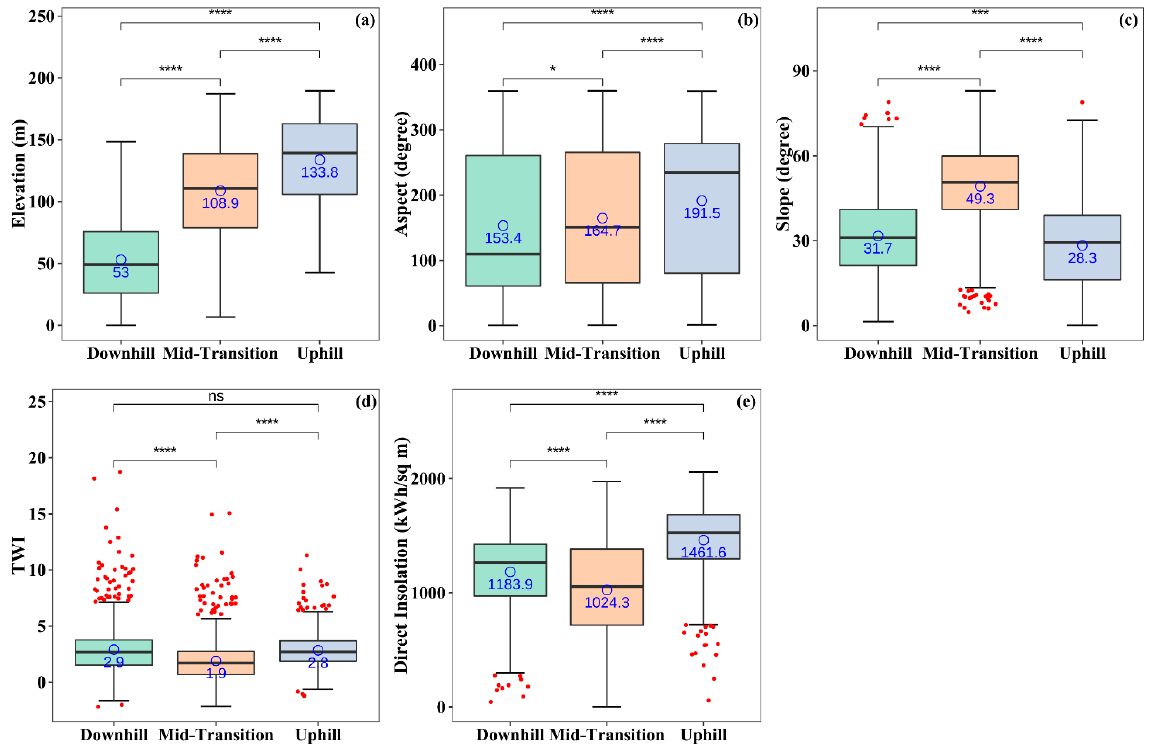
Figure 6. Significance boxplot of topographical indexes on different landform units. ( a ) Elevation; ( b ) Aspect; ( c ) Slope; ( d ) Topographic Wetness Index; ( e ) Direct Insolation. Blue circles and numbers are the mean values of each group. Red dots are the outliers. The p -value levels are symbolized as (1) ns: p > 0.05, (2) *: p < 0.05, (3) ***: p < 0.001, (4) ****: p < 0.0001.